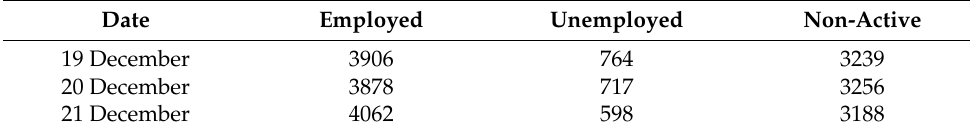
Table 1. Greece’s unemployment indexes (in thousands).